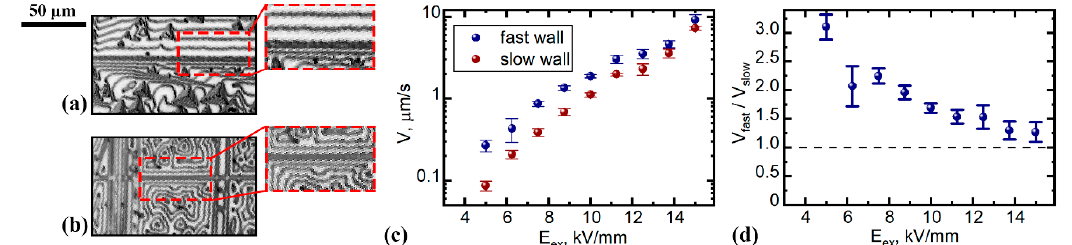
Figure 8. ( a , b ) Fragments of kinetic maps representing the growth of the stripe domains that appeared at the artificial linear surface defects, E ex , kV/mm: ( a ) 6.25 and ( b ) 15. Time intervals between subsequent wall positions, s: ( a ) 15 and ( b ) 0.5. Field dependences of ( c ) fast (close to Y+) and slow (close to Y–) wall velocities, and ( d ) the ratio of fast to slow wall velocities.